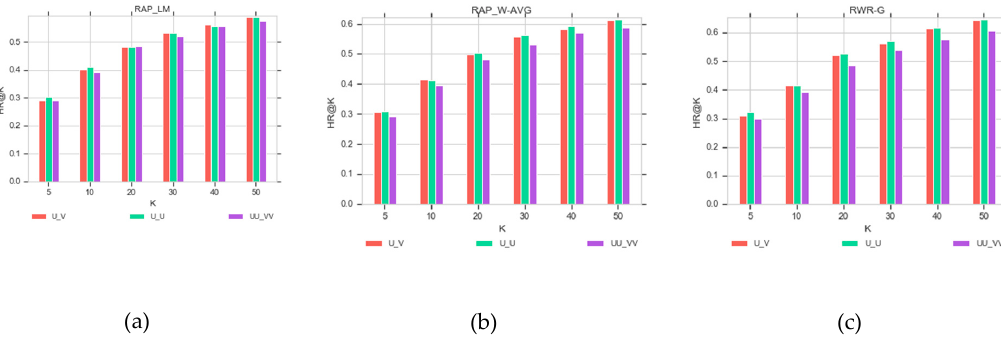
Figure 6. Values of HR@K index (vertical axis) of CLGRW in three group recommendation strategies: ( a ) RAP_LM; ( b ) RAP_W-AVG, and ( c ) RWR-G using different numbers of recommendations (horizontal axis) and three graph models: U-V, U-U, and UU-VV graphs. U-V: the user-location graph; UU-VV: the user and location neighborhood graphs added to the user-location graph, U-U: the user relationship graph added to the user-location graph.